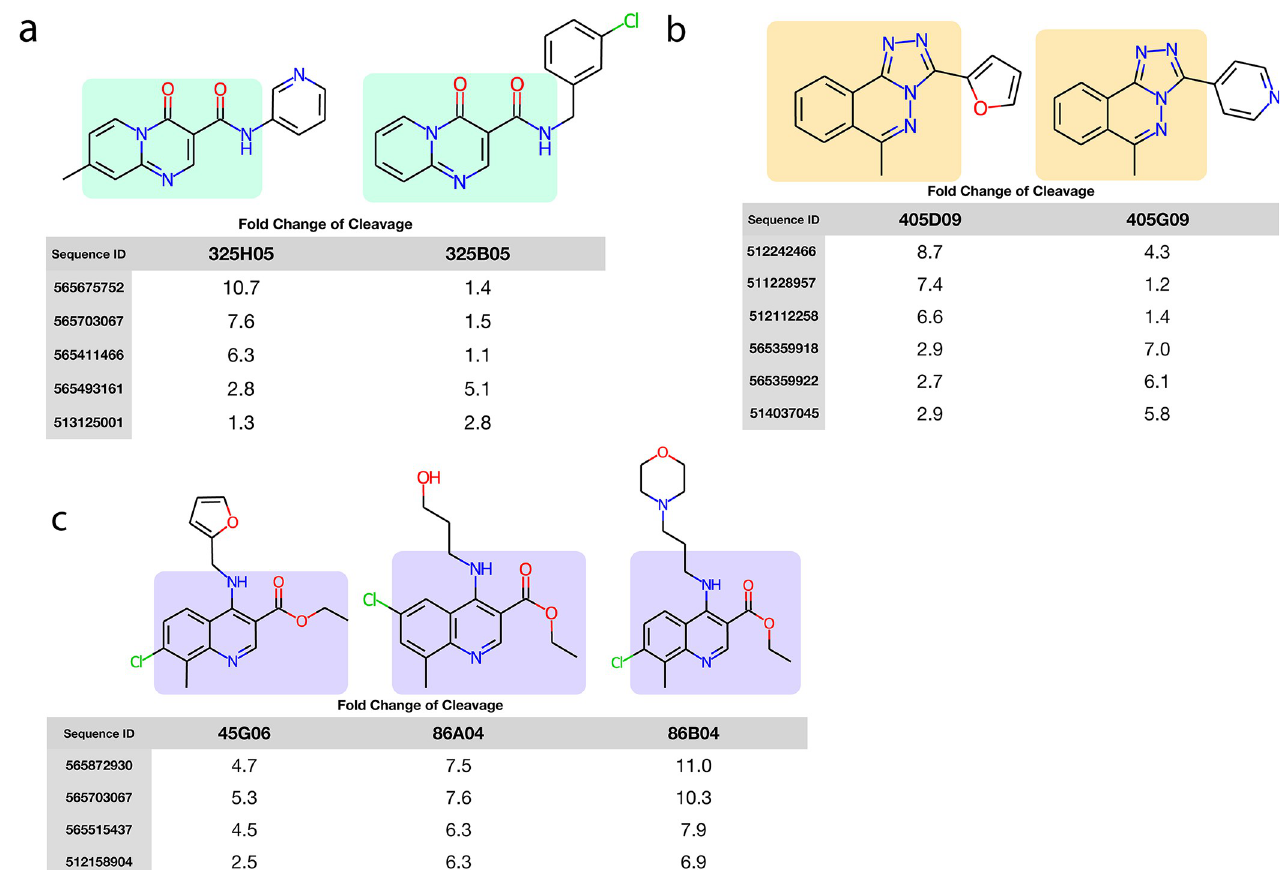
Fig 7. Biosensors can discriminate between similar compounds that differ by a single functional group. Each panel consists of a set of similar compounds and a selection of biosensors that show selective sensing between the compounds. Measurements were taken individually with all compounds at the same concentrations. (a) Compounds 325H05 and 325B05 share a common pyrido[1,2a]pyrimidine core each with a carboxamide bearing a pendant cyclic group (pyridyl and chlorobenzyl, respectively). (b) Compounds 405D09 and 405G09, share a common methyl-triazolo-phthalazine bearing pendant cyclic groups, furan and pyridine, respectively. (c) Compounds 45G06, 86A04 and 86B04, all of which share a common chloro–8-methyl–4-methylamino quinoline with an ethyl carboxylate. Attached to the methylamino are a furan, ethanol, and morpholine, respectively.